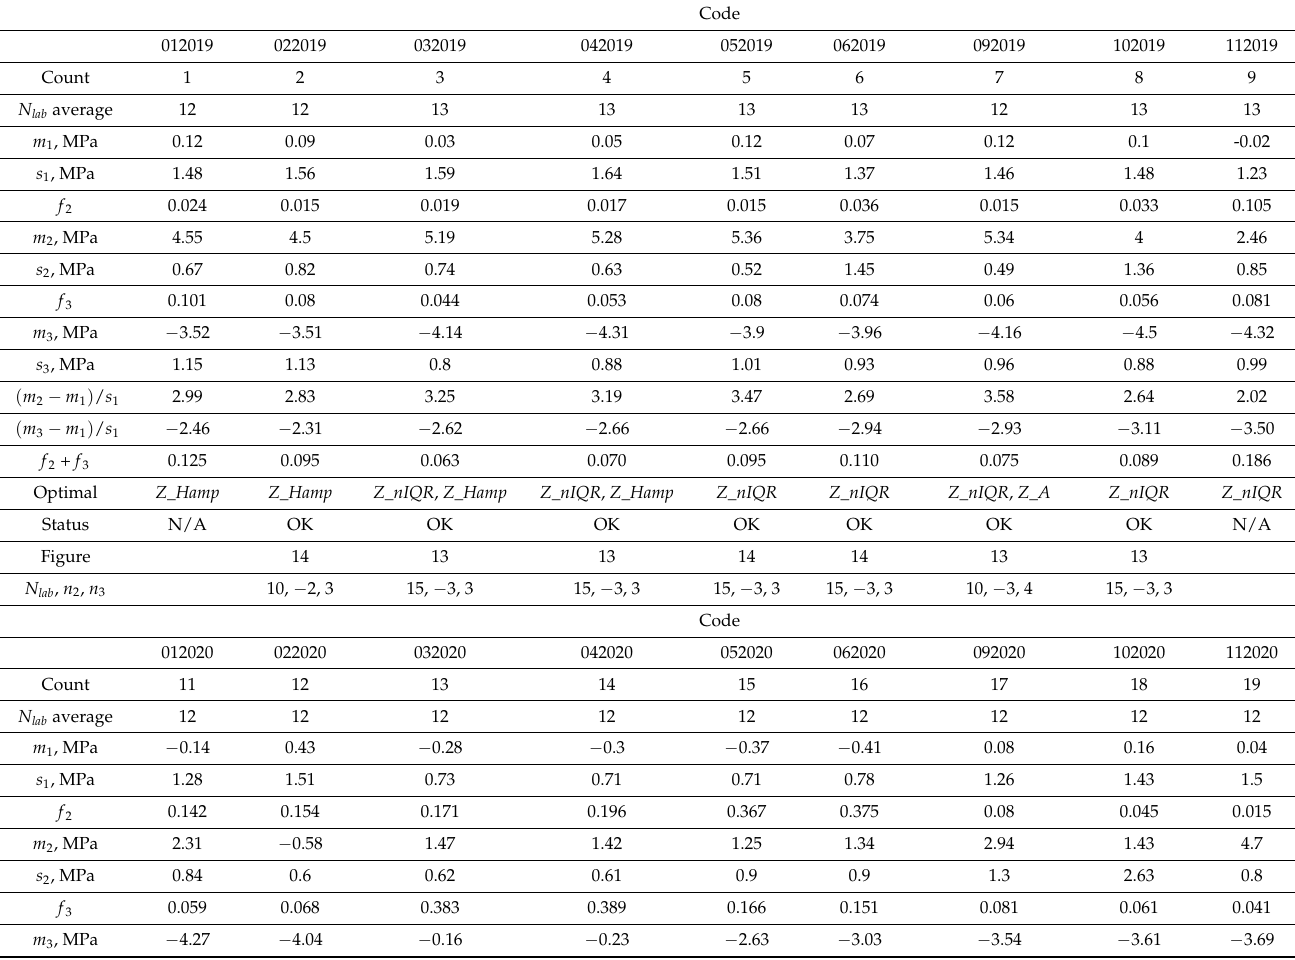
Table 5. Normal distribution parameters and optimum robust estimators for 18 consecutive 28-day strength